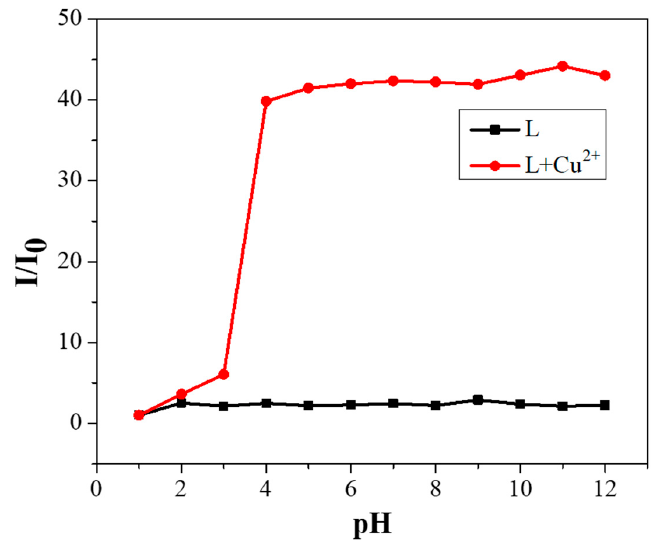
Figure 9. Fluorescence response (438 nm) of free probe L (10 µ M) after adding Cu 2+ in ethanol–water ( v / v = 7/3, 5 mM HEPES, pH 7.0) solutions as a function of pH values. (at λ ex = 380nm with excitation slit = 5 nm and emission slit = 5 nm).